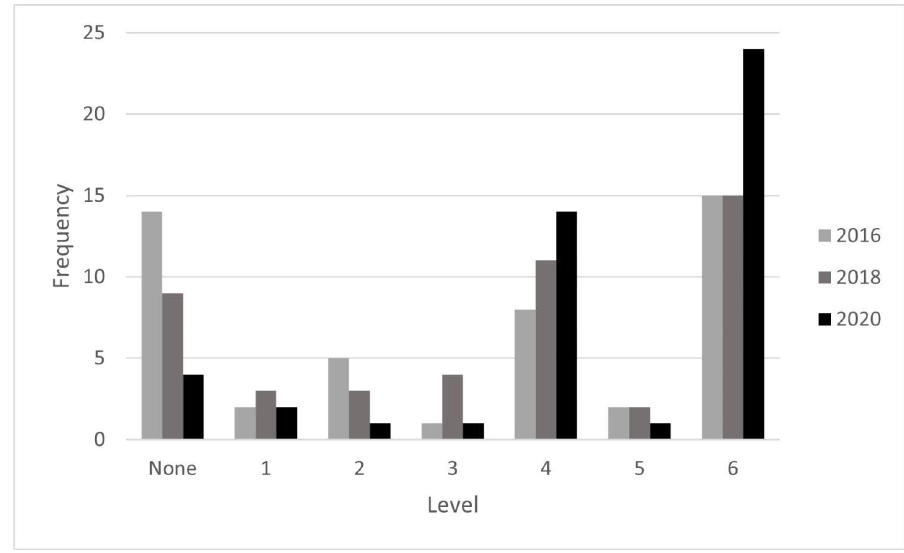
Fig. 3 Multi-Year Frequency Distribution of Firms’ CSR